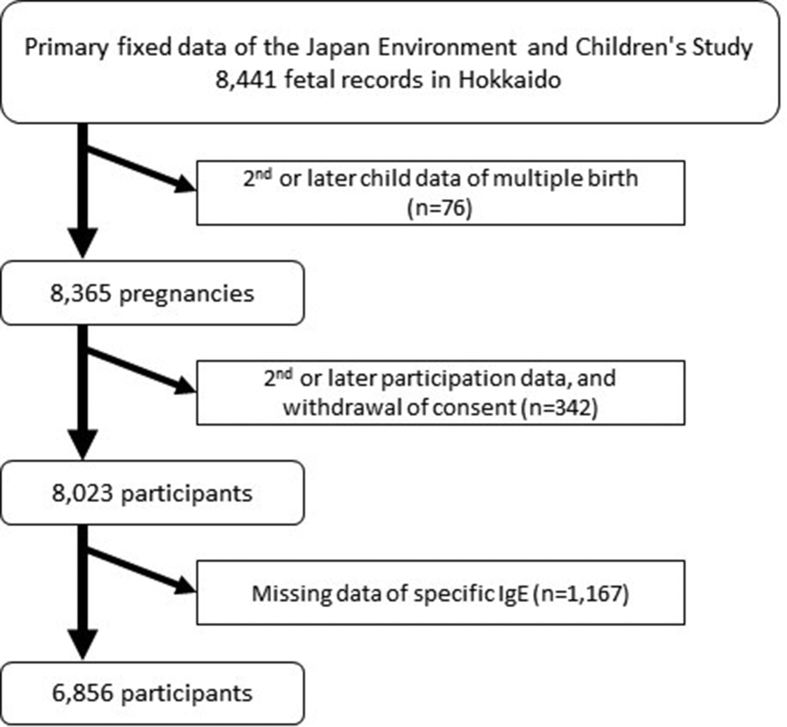
Flow diagram of study participants